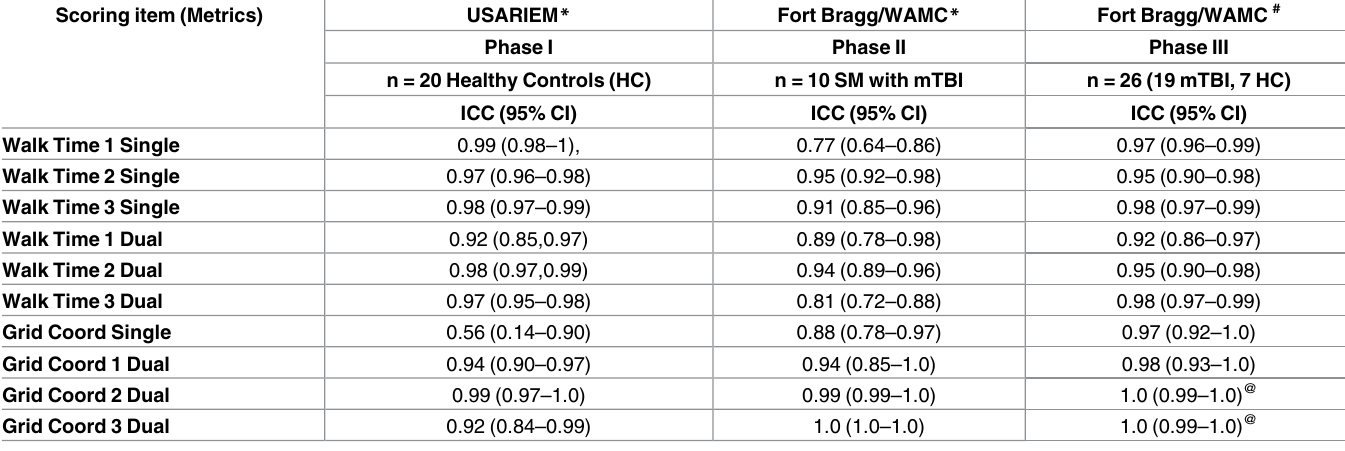
Table 5. Instrumented Stand and Walk-Grid Coordinates (ISAW-grid)